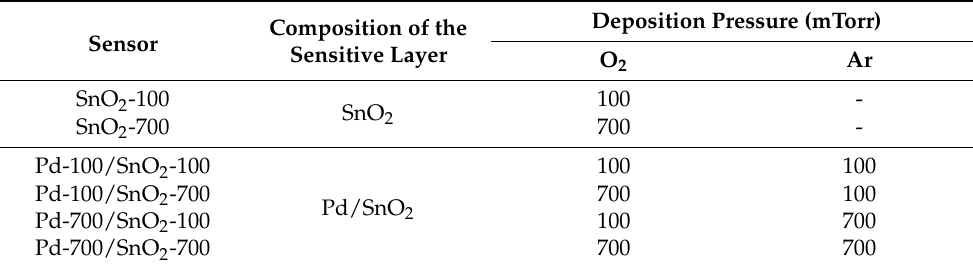
Table 1. The sensors and the thin film deposition characteristics. Composition of Sensor